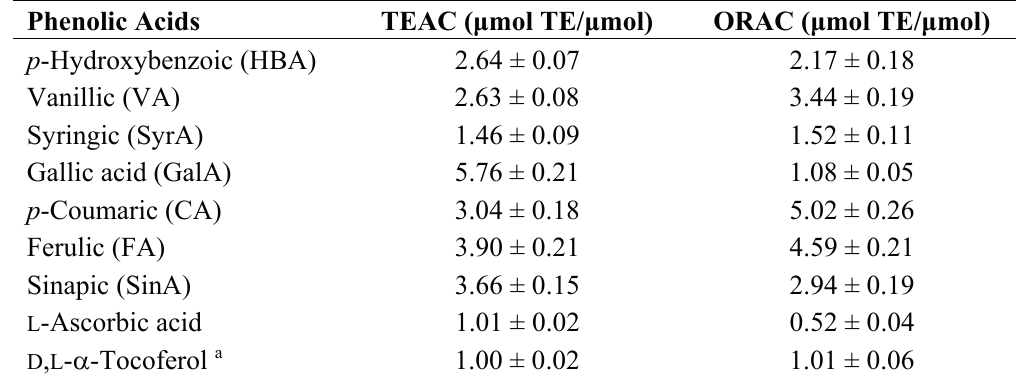
Table 2. Antioxidant capacity of HB and HC acids against the 2,2'-azino-bis-(3- ethylbenzothiazoline-6-sulphonic acid) diammonium salt (ABTS) radical cation (Trolox Equivalent Antioxidant Capacity—TEAC, 50 µM PBS, pH 7.4) and peroxyl radical (Oxygen Radical Absorbance Capacity—ORAC, 75 µM Na-phosphate buffer, pH